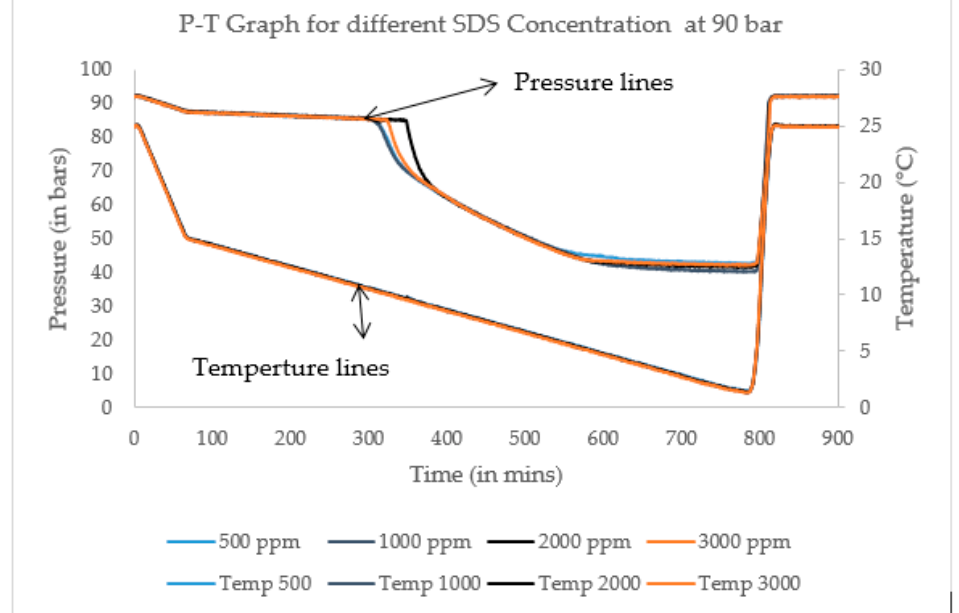
Figure 1. Rocking cell experiment showing pressure and temperature as a function of time during a constant ramping run for four cells. Each cell contains different SDS concentrations (500 ppm to 3000 ppm) (fresh). Initial pressure is 90 bar while temperature ramping started from T = 15 ◦ C to 3 ◦ C in 12 h. As the temperature decreases hydrate formation is shown as a sudden drop in pressure. Upon